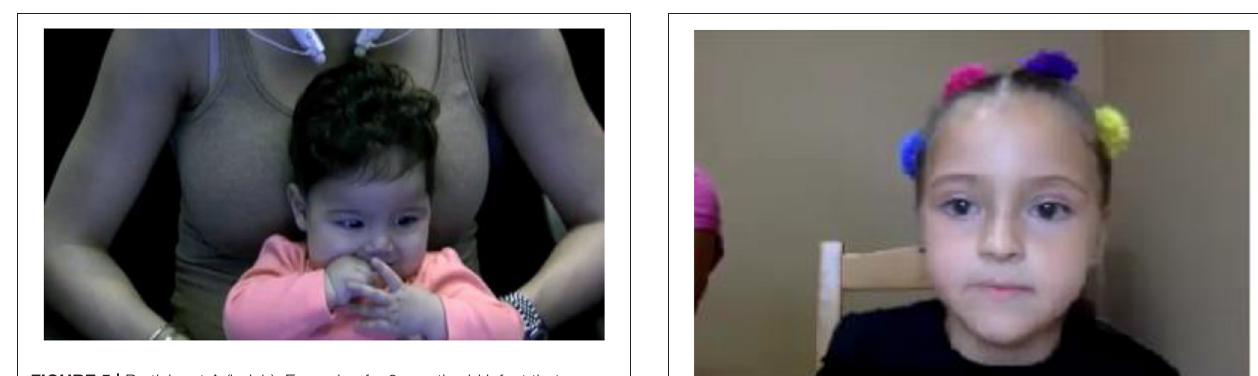
FIGURE 5 | Participant A (in-lab). Example of a 6-month-old infant that OpenFace may have trouble identifying all components (facial landmark, head pose estimation, facial action unit recognition, and eye-gaze estimation) due to obstruction (hand) of the child’s face.